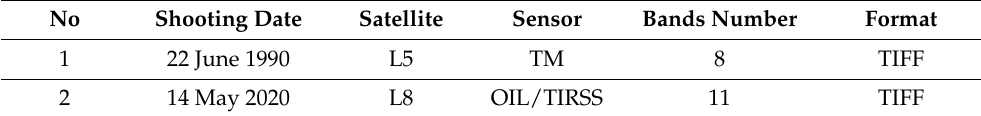
Table 1. Landsat 5 and 8 satellite images between the years 1990 and 2020. No Shooting Date Satellite Sensor Bands